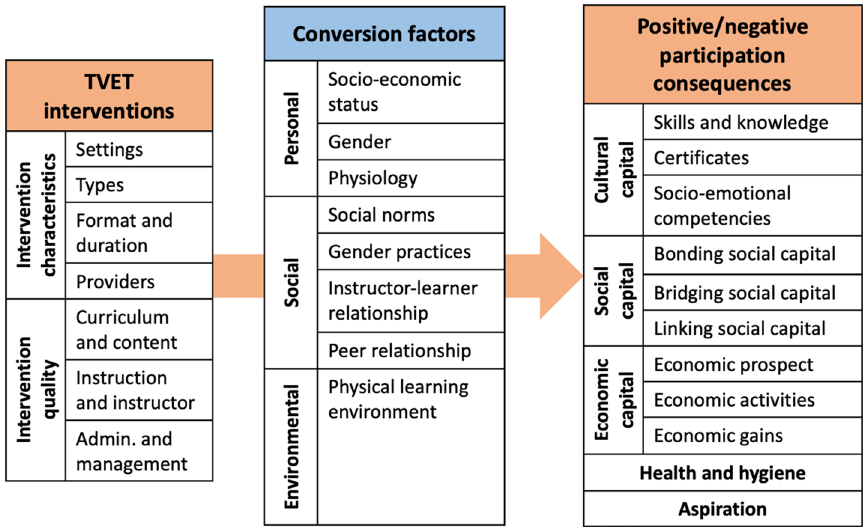
Fig. 2 A Summary Framework of Young People’s TVET